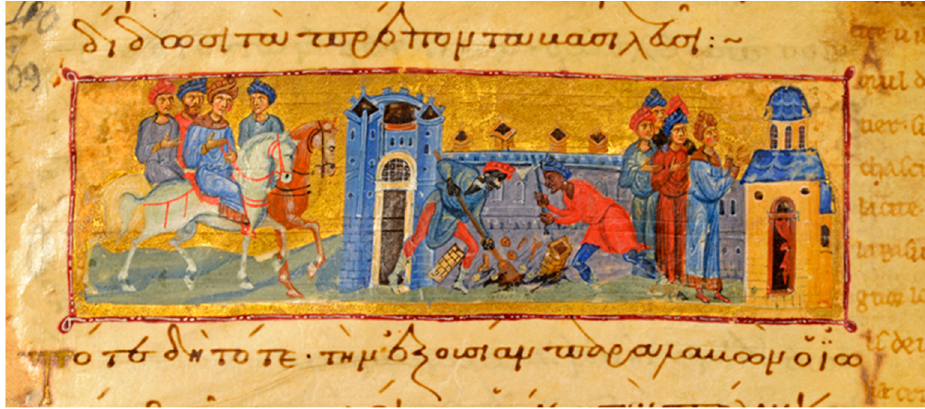
Figure 10. Mount Athos. Holy Iviron Monastery. Athon. Iviron 463, fol. 109r (detail). Ioasaph orders the destruction of idols and the building of a church. Photo: ©Holy Iviron Monastery, Mount Athos, all rights reserved.